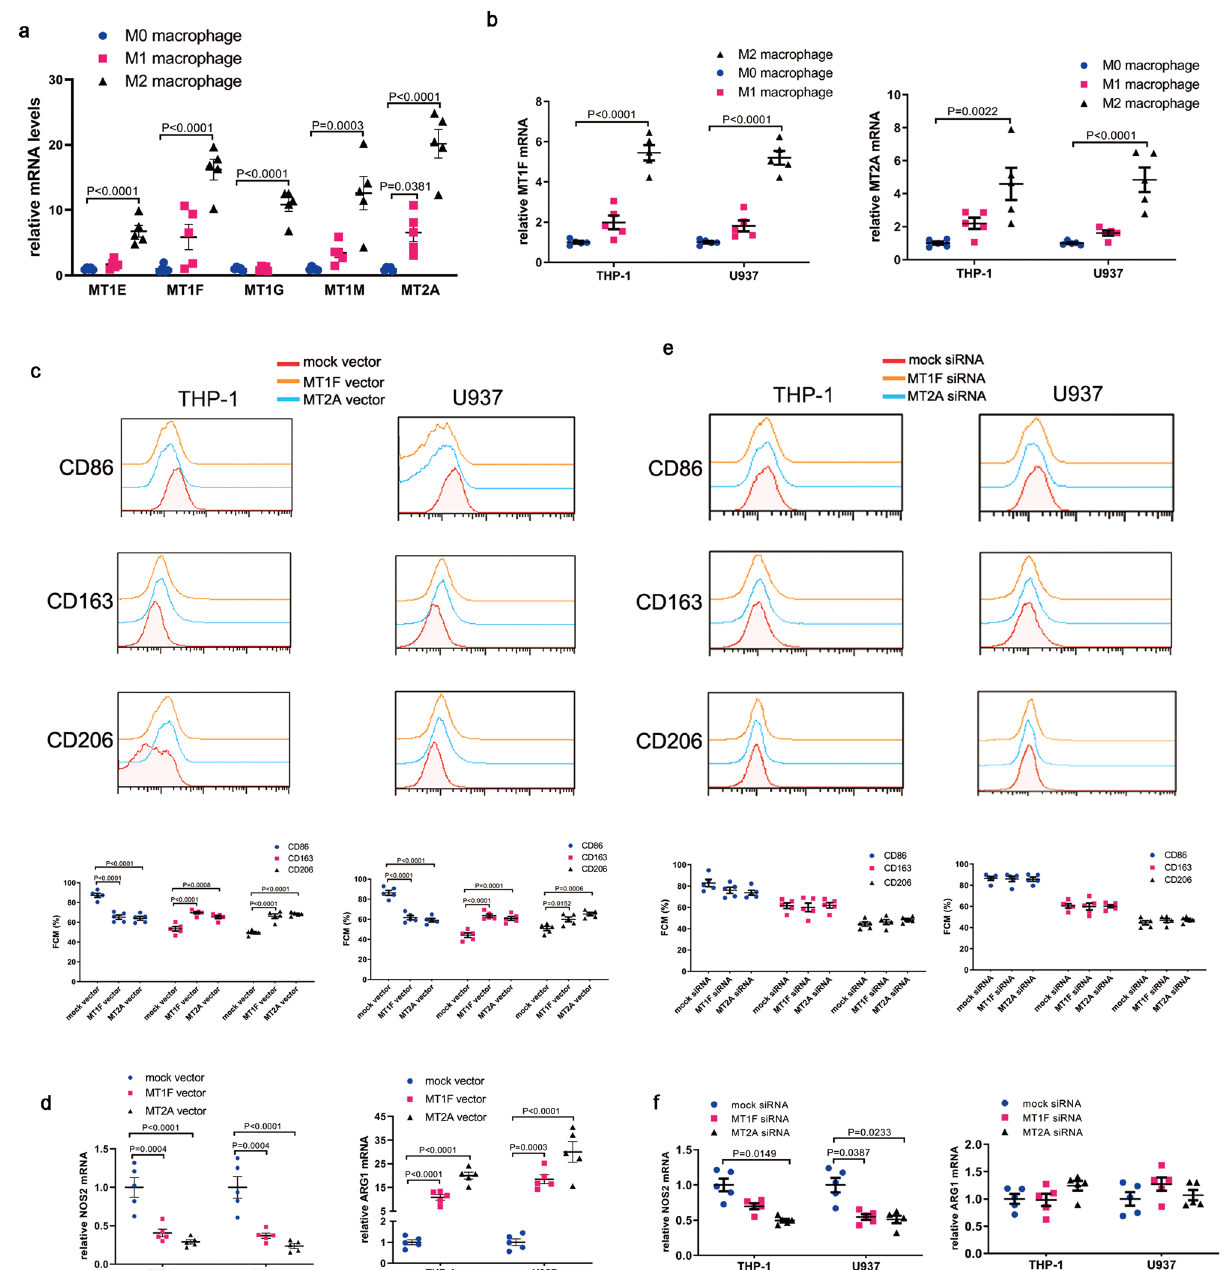
Fig. 8 Higher MT expression promoted pro-repair macrophages polarization. a MT expression is differentially polarized MDM. b MT1F and MT2A expression in differentially polarized THP-1 and U937 cells. c , d The overexpression of MT1F and MT2A in THP-1 and U937 cells induced pro-repair macrophages polarization. e , f The knockdown of MT1F and MT2A in THP-1 and U937 cells had no effect on macrophage polarization. Data represent the mean value ± SEM of fi ve individual experiments ( n =